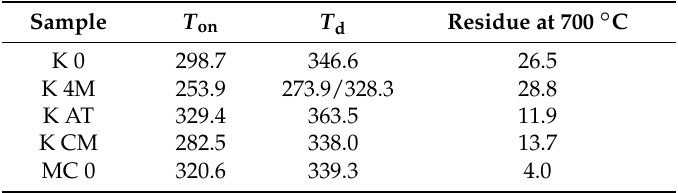
Figure 10. Thermogravimetric analysis (TGA) ( a ) and derivative thermogravimetry (DTG) ( b ) curves in inert atmosphere of Kombucha pellicles. Table 3. Values of the onset degradation temperature ( T on ), the temperature at the maximum degradation rate ( T d ) and residue for Kombucha-derived cellulose samples.